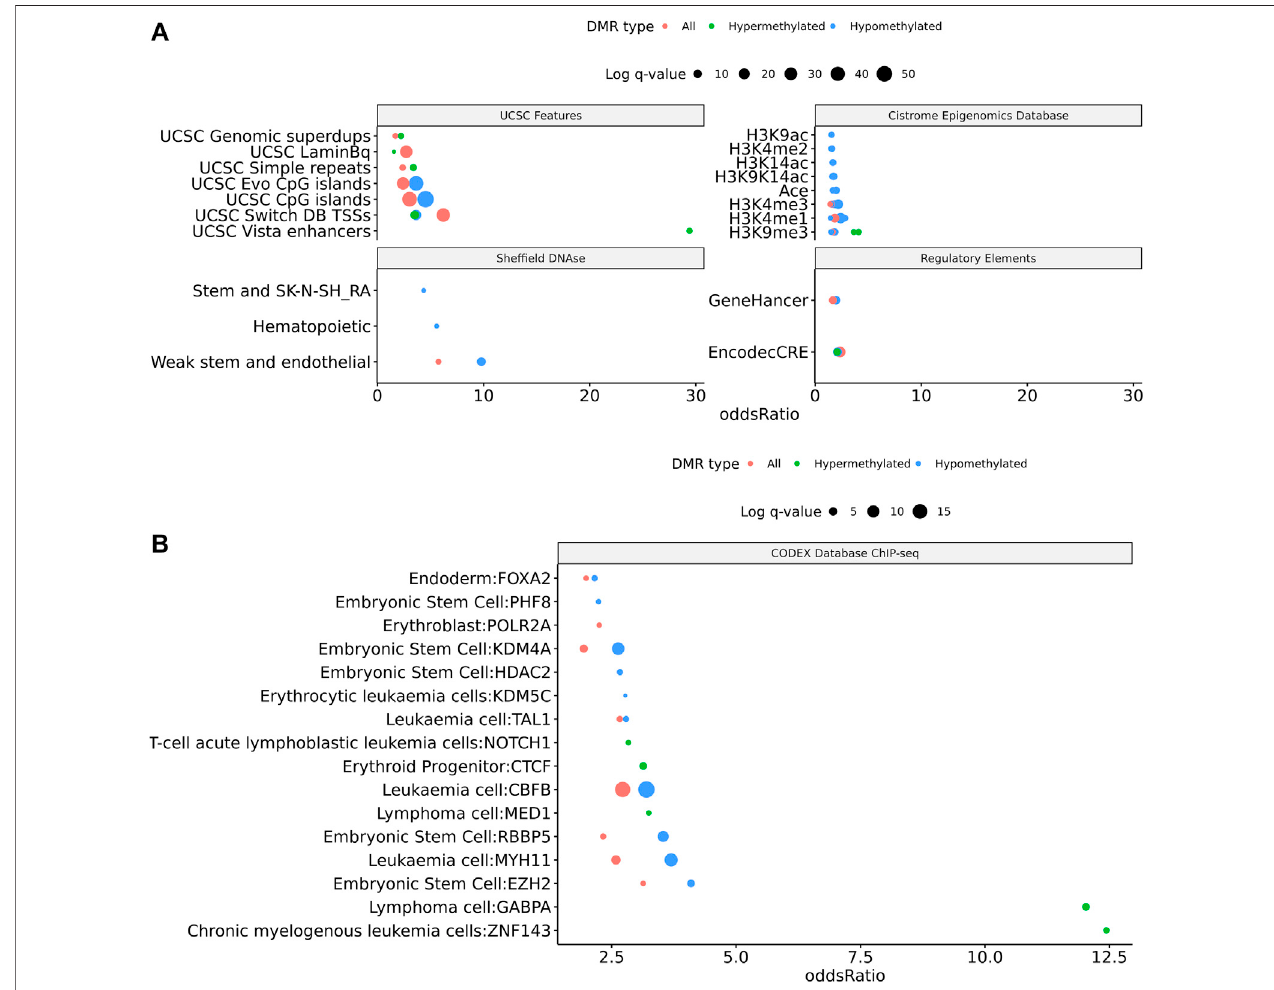
FIGURE 5 | 414 DMRs were detected in TS v. 46, XX which are largely hypomethylated and near protein coding regions. (A) Volcano plot of all regions detected colored by DMR type, hypermethylated, hypomethylated, or not signi fi cant with dashed lines at − log10 (0.1) and ±10% methylation difference. (B) Barplot of gene type annotations for all genes overlapping DMRs or the nearest gene when DMRs lack